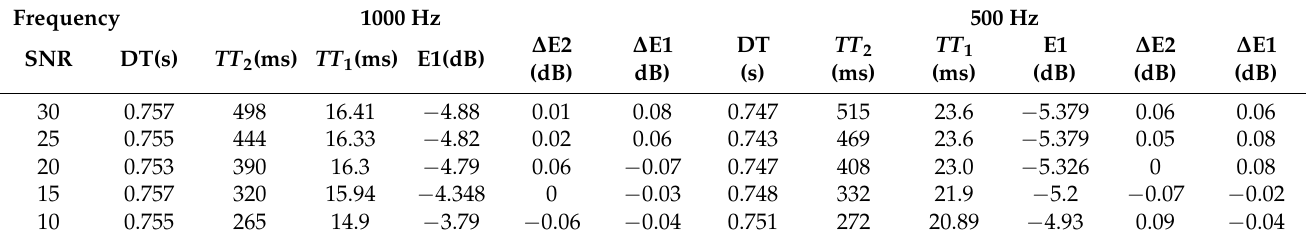
Table 1. Comparison of DT and TT s between the measured RIRs with added pink noise.